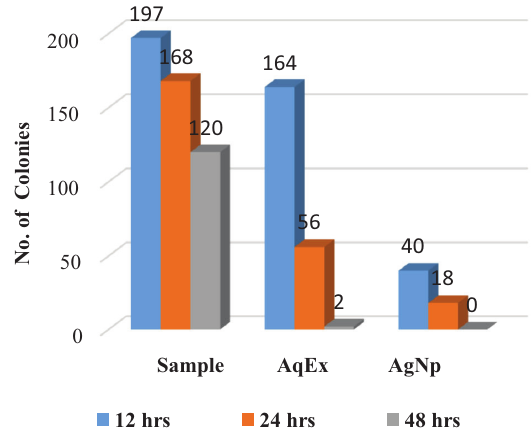
Figure 8. Total bacterial count ( E.coli ) in Macckonkey Agar – values are expressed as Mean ( n = 3)